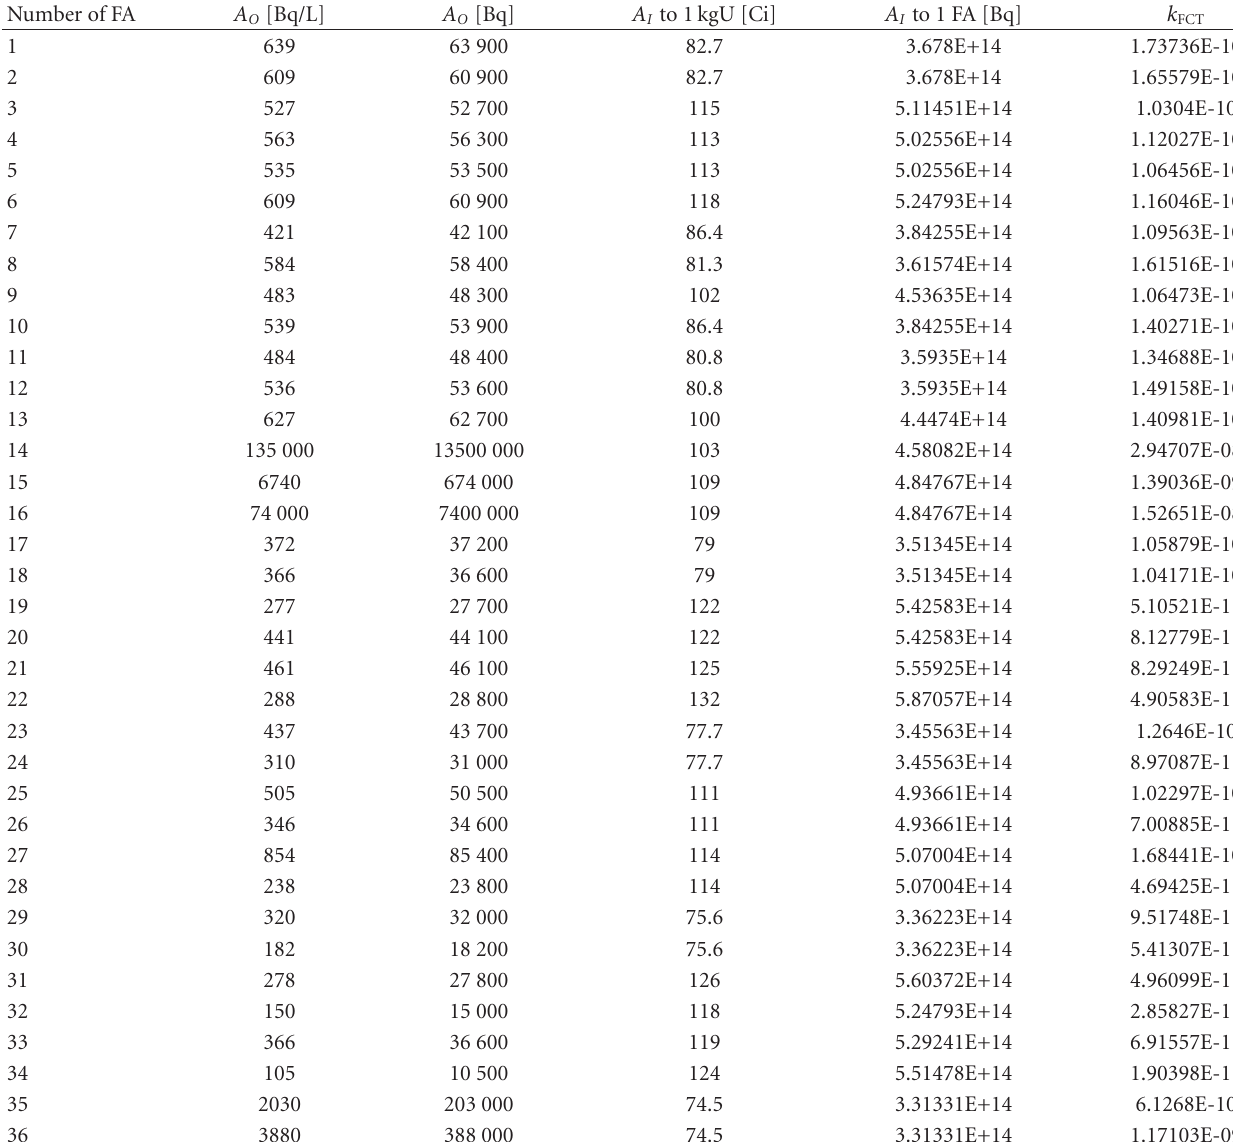
Table 1: Measured and calculated values of A O and A I and final calculation of k FCT